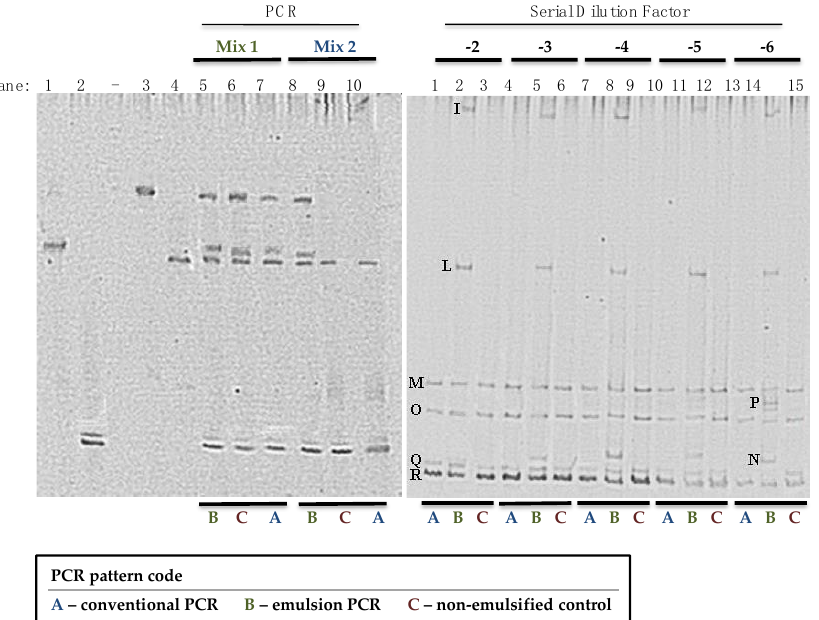
Figure 1. Denaturing gradient gel electrophoresis (DGGE) profiles of mixtures of amplicons obtained from DNA extracted from lactic acid bacteria (A) and DNA extracted directly from bulk-collected coagulase-negative catalase-positive cocci (CNCPC) cells. Panel A: Lane 1, Lc. lactis ; lane 2, Leuc. mesenteroides ; lane 3, P. pentosaceus ; lane 4, Lb. sakei ; lane 5, ePCR (mix 1); lane 6, not emulsified control (NEC), non-emulsified control (mix 1); lane 7, conventional PCR (mix 1); lane 8, ePCR (mix 2); lane 9, NEC, non-emulsified control (mix 2); lane 10, conventional PCR (mix 2). Mix 1: DNA of Lactobacillus sakei (DSMZ 6333), Lactococcus lactis (DSMZ 20481), Leuconostoc mesenteroides (DSMZ 20241) and Pediococcus pentosaceus (DSM 20336) at the same concentration (100 ng · µ L − 1 ). Mix 2: DNA of the lactic acid bacteria was added at di ff erent concentrations: 500 ng · µ L − 1 Lb. sakei , 300 ng · µ L − 1 Lc. lactis , 150 ng · µ L − 1 Leuc. mesenteroides and 50 ng · µ L − 1 P. pentosaceus . Panel B: PCR, conventional PCR; ePCR, emulsion PCR; NEC, non-emulsified control; 10 − 2 , 10 − 3 , 10 − 4 , 10 − 5 , 10 − 6 , sample dilution on MSA agar at which the colonies were harvested in bulk and subjected to total DNA extraction and PCR / ePCR analysis.